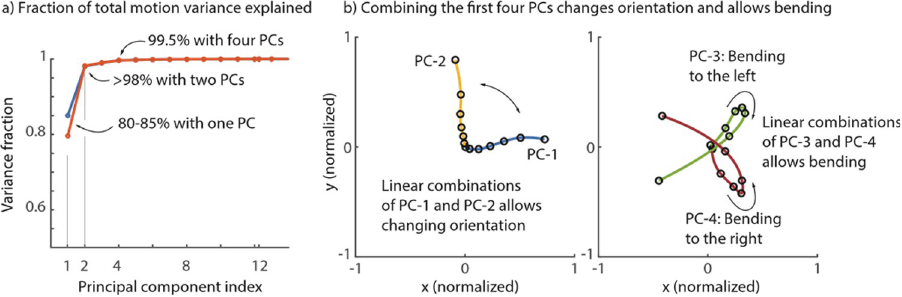
Fig 5. Dimensionality of the bending filament. (A) We find that one principal component captures about 80% of the variance across a whole thirty-exposure trial. Two principal components capture over 95% and four capture over 99.5%. Curves are shown for specimen 5 (blue) and specimen 6 (red). (B) The shapes of the principal components are shown; linear combinations of the first two PCs produce different orientations and the third and the fourth PCs control bending to the left versus the